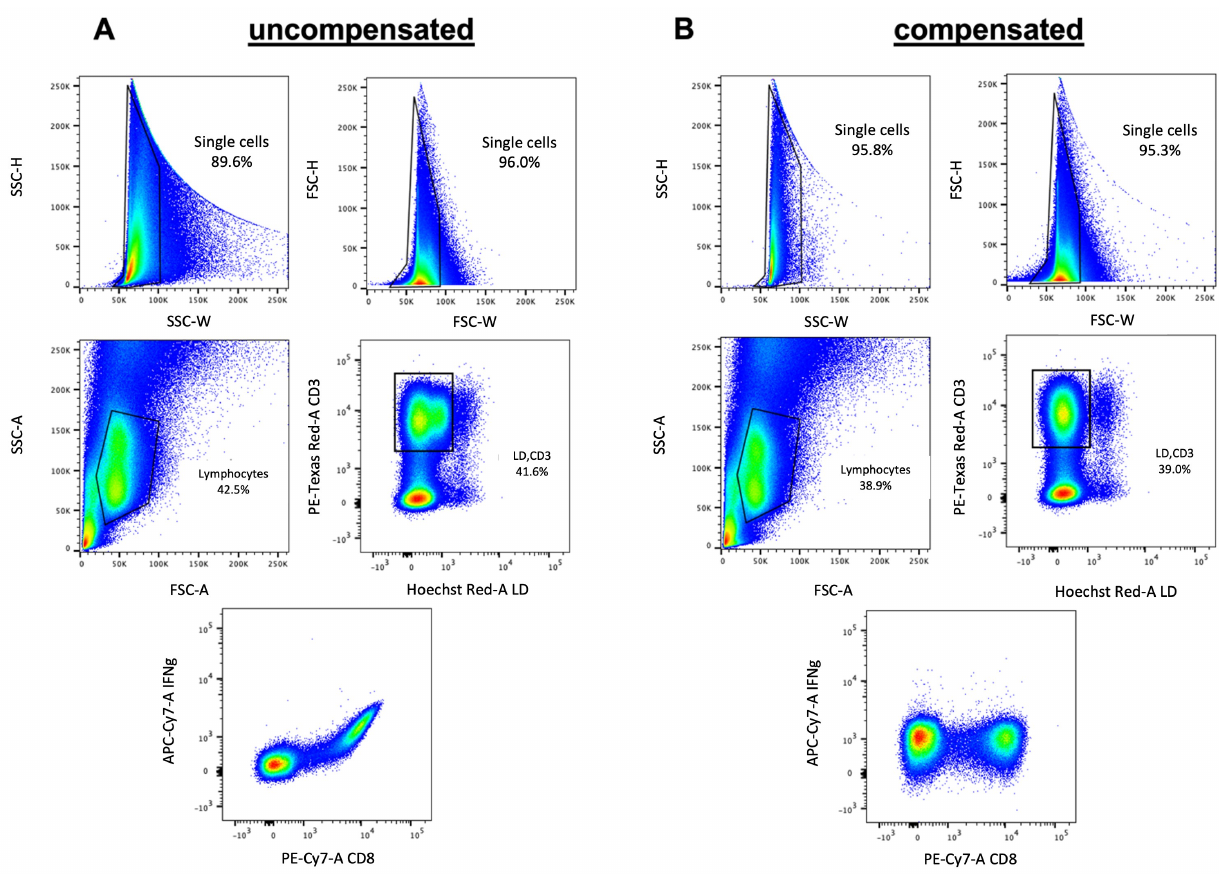
Figure 5. Analytical pitfalls in FACS analysis. When working with a 15–20 color panel, compensation is of utmost importance. ( A ) shows the gating of a human peripheral blood mononuclear cells (PBMCs) sample before compensation. ( B ) displays the same file after automatically applying the compensation in FlowJo, a software application that has an integrated environment for viewing and analyzing flow cytometric data [26]. Due to the nature of flow cytometry, the emission of a specific dye in a mixture of dyes is usually measured not only in a single detector but in all detectors being used in the specific experiment. During compensation, the signals of any other fluorochrome are removed except the one devoted to measuring that dye by calculating and subtracting the spillover values of them. Therefore, for each fluorochrome used in the experiment, a single-stained sample must be analyzed in parallel. Although the need for compensation can be avoided by using fluorophores that do not have overlapping emission spectra or combining fluorophores that can be uniquely activated by specific laser lines, compensation will be usually necessary when using panels with a large number of different